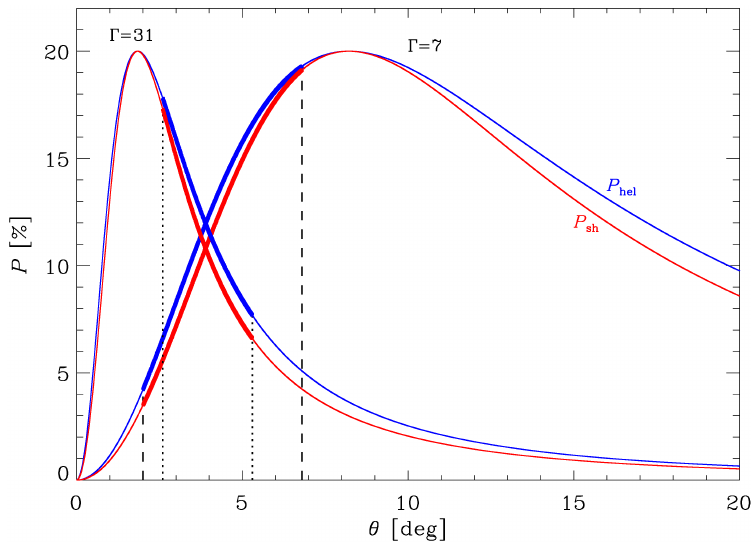
Figure 1. Comparison of the behaviour of the polarisation degree versus the viewing angle of the optical emitting region in 4C 38.41 and BL Lacertae. 4C 38.41 has a greater bulk Lorentz factor ( Γ = 31) than BL Lacertae ( Γ = 7), which makes the P curve of 4C 38.41 reach a maximum for a viewing angle much smaller than in the BL Lacertae case. Therefore, for the range of θ (indicated by vertical lines) required to explain the long-term observed variability in the geometrical model, P decreases for increasing θ (and thus for decreasing flux) in the 4C 38.41 case, while the opposite occurs for BL Lacertae. The blue and red lines refer to the helical magnetic field and shock-in-jet models, respectively. Figure adapted from